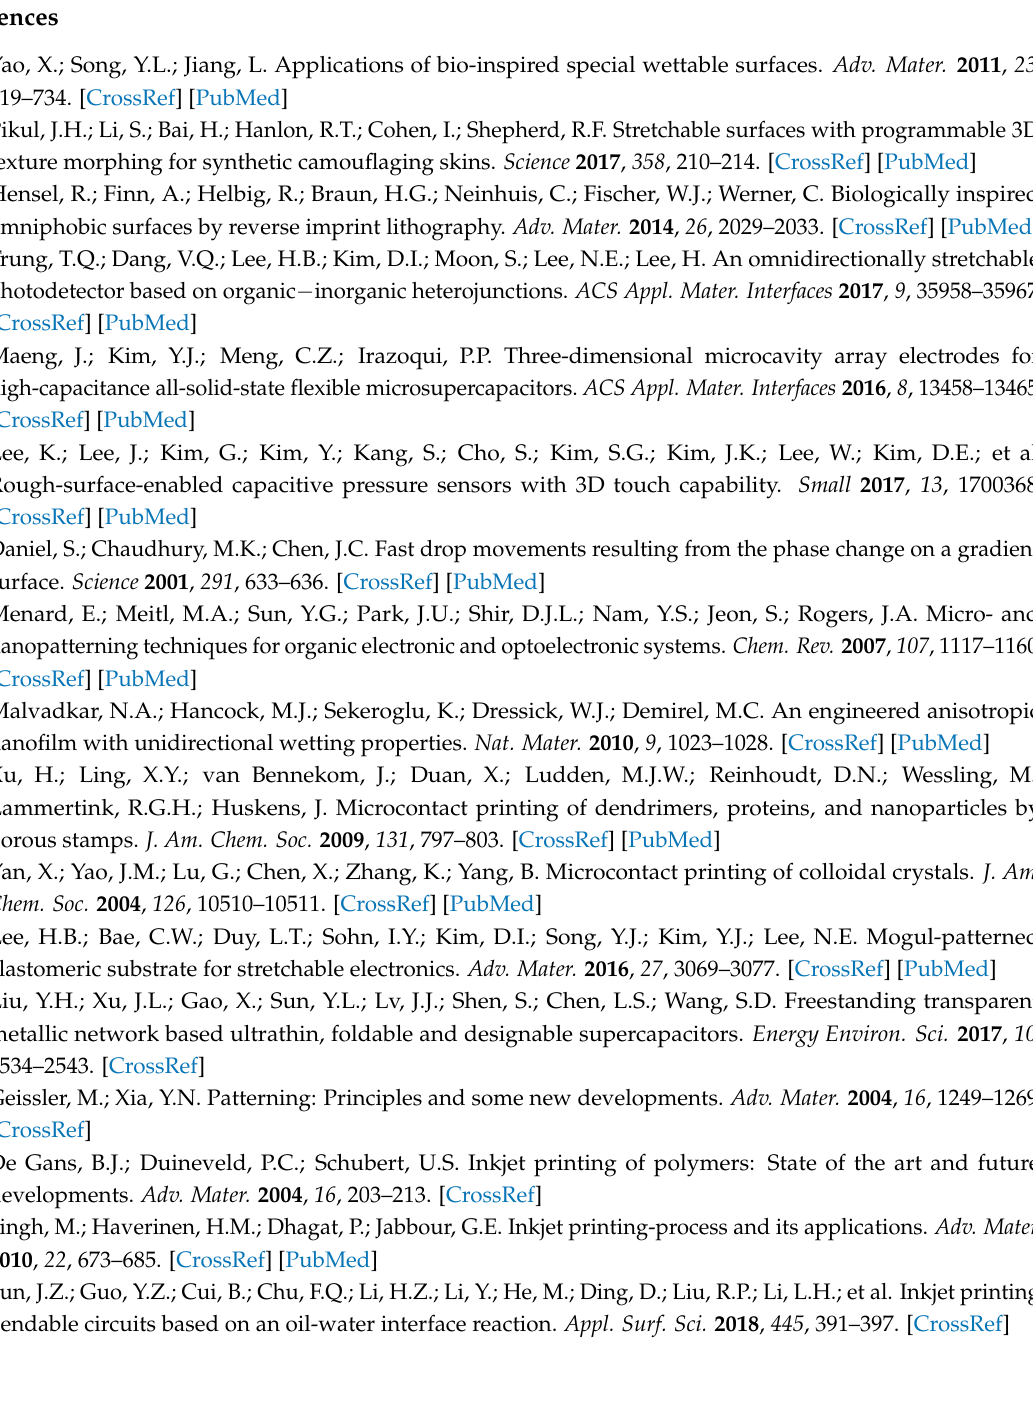
Figure S2: SEM image of etched square template for fabricating microstructured surfaces with raised squares, Figure S3: Optical image of the high magnification images of raised dot microstructured surface, fabricated based on the etched template, Figure S4: Structuring of complicated designs with one gradient microstructure fabricated based on two types of the etched line template, Figure S5: Profiles of the raised line microstructured surface fabricated based on the etched